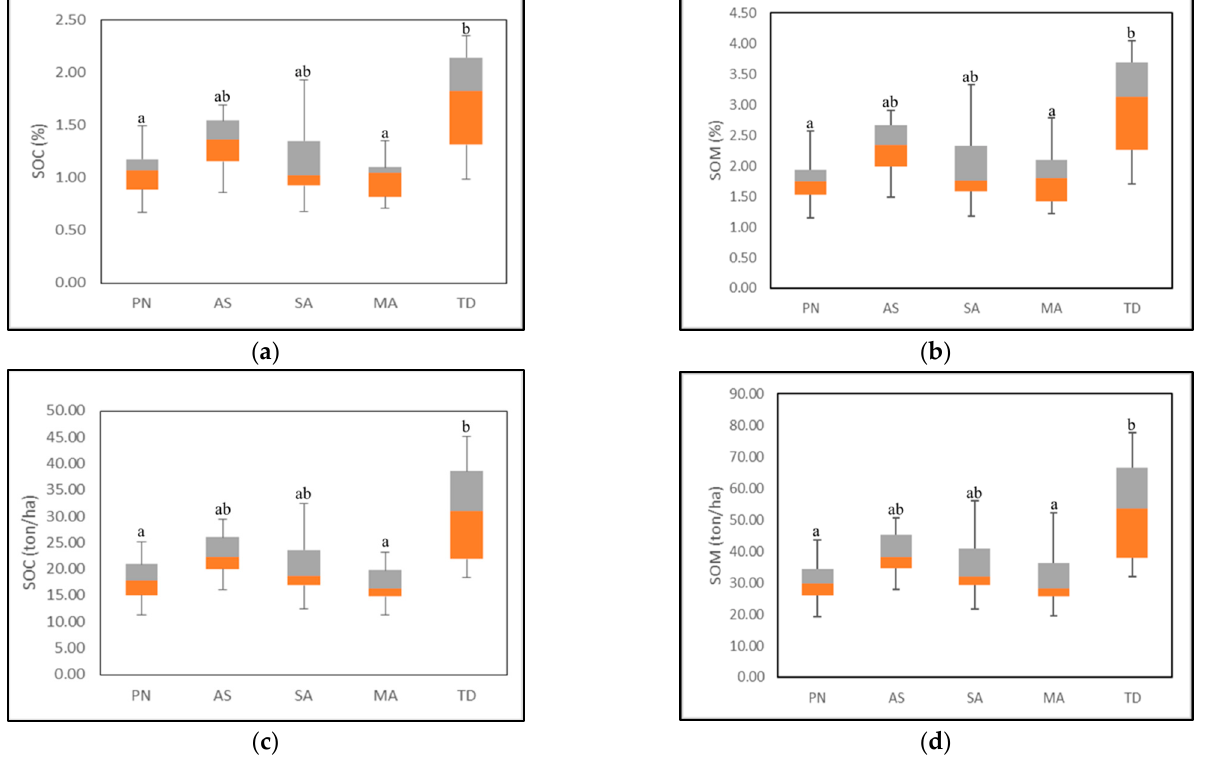
Figure 2 . Variations in SOC and SOM among stand types; ( a ) SOC concentration, ( b ) SOM concentration, ( c ) SOC stock and ( d ) SOM stock. Yellow and grey areas of the boxes indicate the second and third quartiles, respectively. Whiskers imply the upper and the lower quartile. Different letters (a,b,c) demonstrate significant differences between plot groups (Annova, p < 0.05).